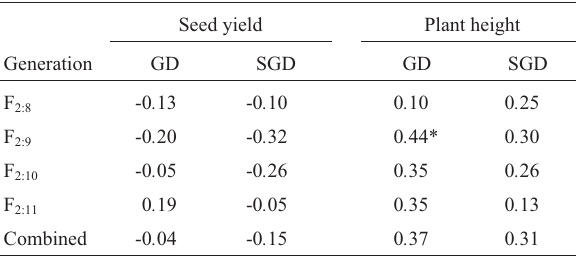
Table 3 - Correlation coefficients between genetic variances (GV) and ge- netic distances (GD) and specific genetic distances (SGD) for seed yield and plant height, for F 2:8 to F 2:11 soybean generations and for the combined analysis. Seed